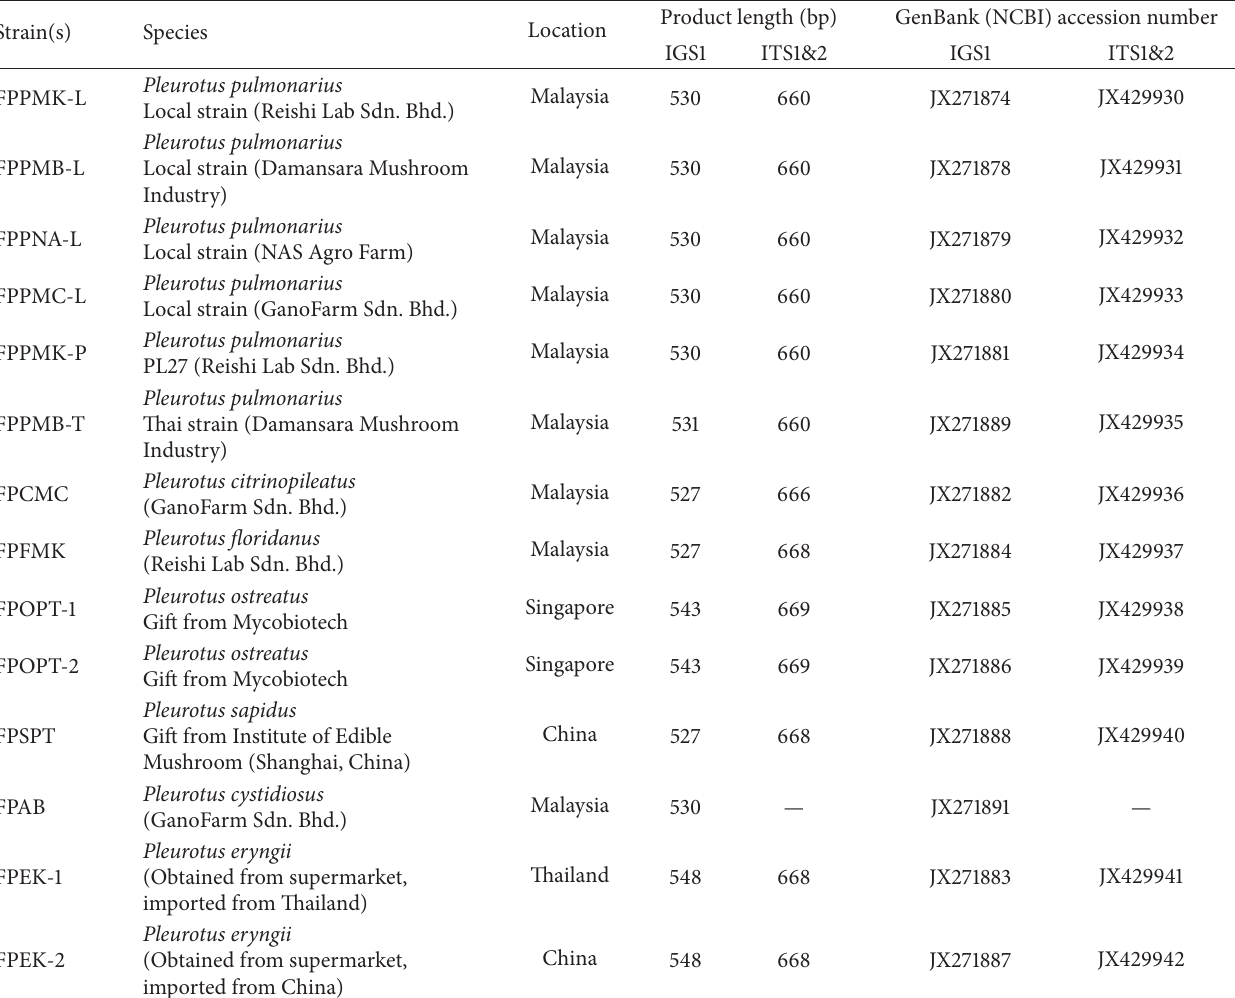
Table 1: Strains and species used in this study and the GenBank accession numbers.